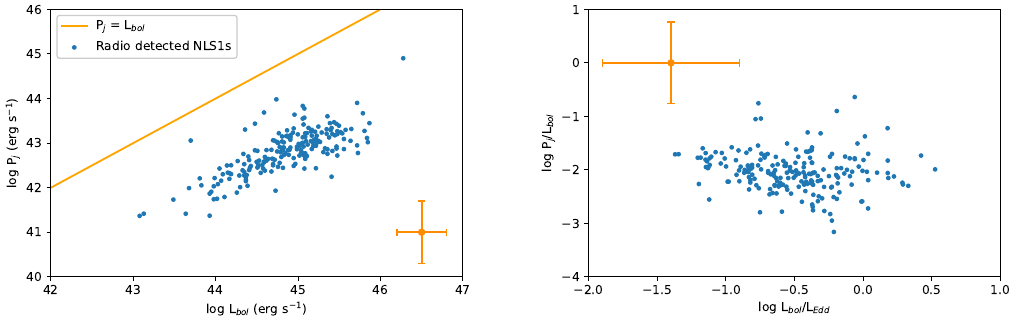
Figure 6. Left panel : The connection between disk luminosity and jet power. The solid line represents the line where the two parameters are equal with each other. Right panel : The connection between Eddington ratio and jet production efficiency. The typical uncertainties are labeled on each